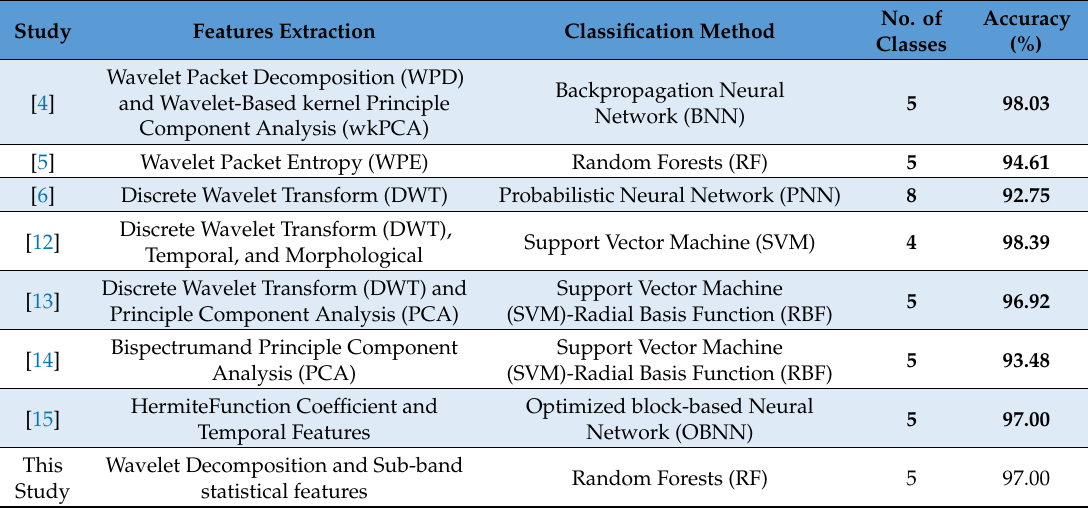
Table 6. Comparison with state-of-the-art